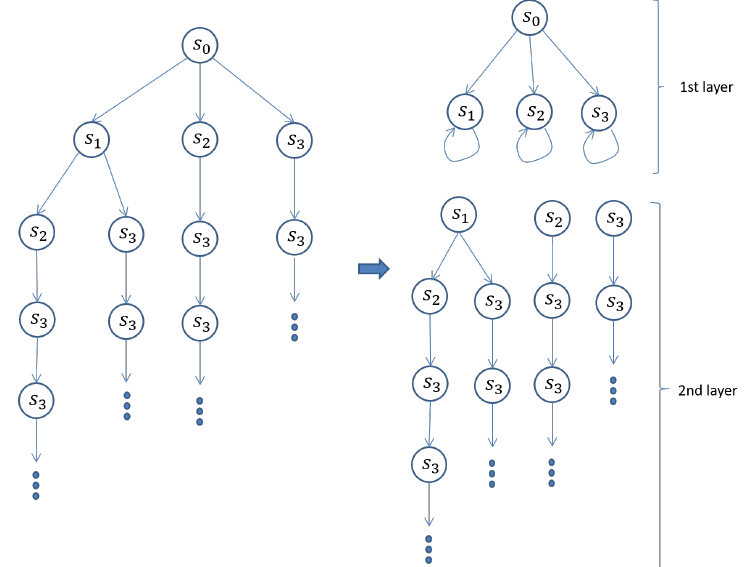
Figure 2. Two-layer division of the SimpSys reachable state